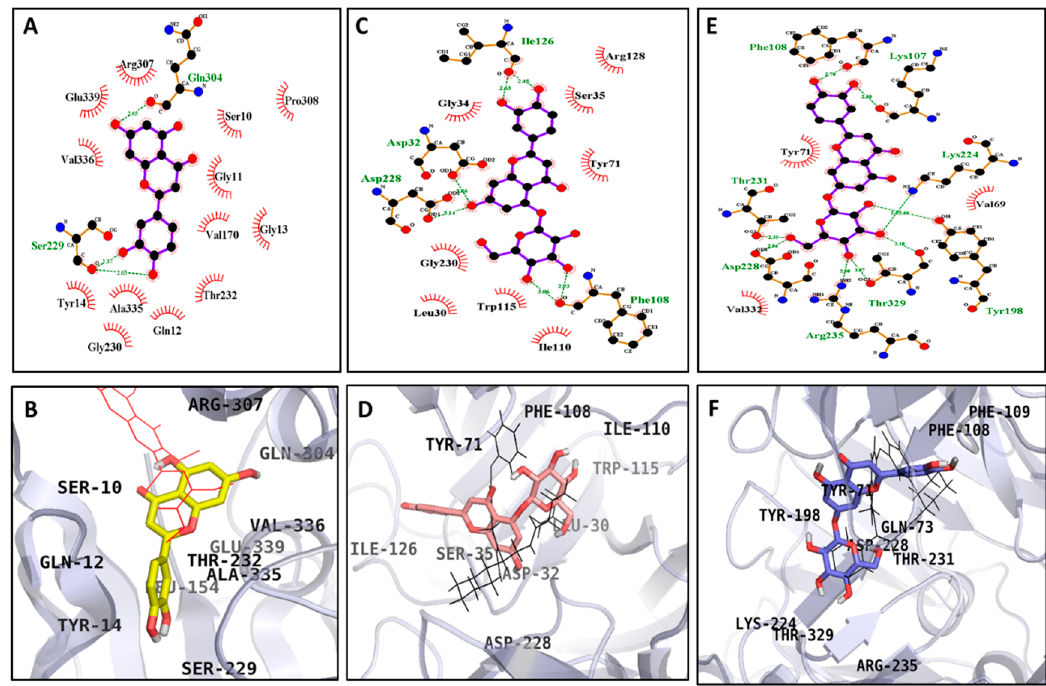
Figure 7. 2D ( A , C , and E ) and 3D ( B , D , and F ) diagrams of BACE1 inhibition by luteolin (allosteric inhibition, A and B ), luteolin 5- O - β - D -glucopyranoside (catalytic inhibition, C and D ), and luteolin 7- O - β - D -glucopyranoside (catalytic inhibition, E and F ). Luteolin, luteolin 5- O - β - D -glucopyranoside, luteolin 7- O - β - D -glucopyranoside, QUD, and PMF are represented by yellow, bold red, blue, black, and red colored structures, respectively.